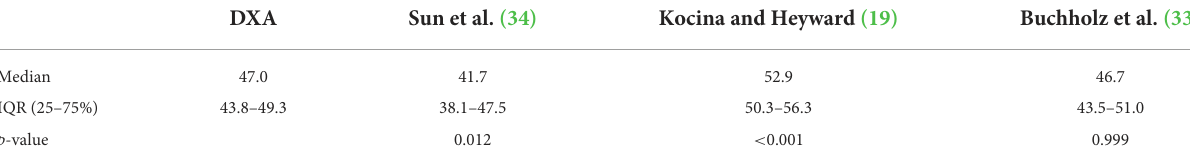
TABLE 3 FFM obtained using DXA and BIA predictive equation (kg).